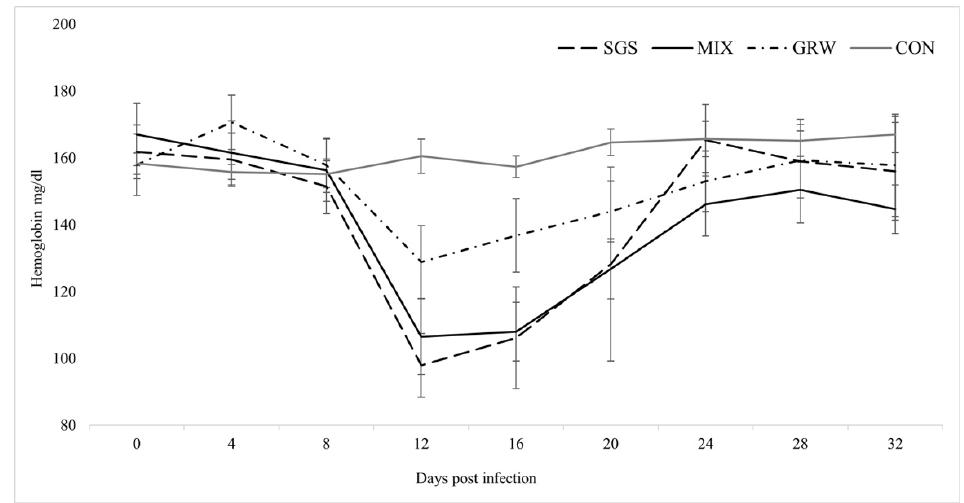
Figure 3. Values of mean hemoglobin level in experimentally infected and control birds. Symbols are as in Figure 2.